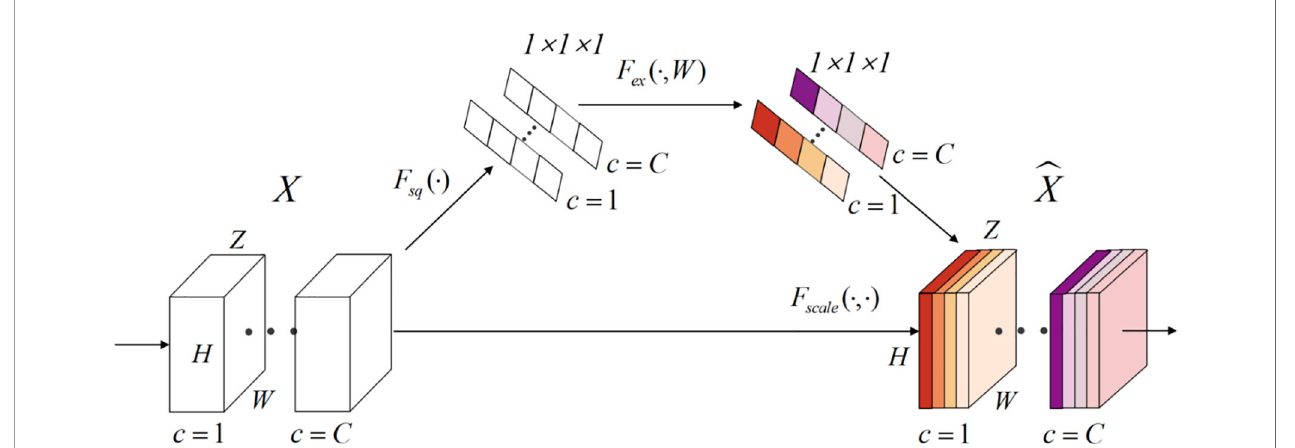
FIGURE 4 | Structure of Squeeze-and-Excitation module